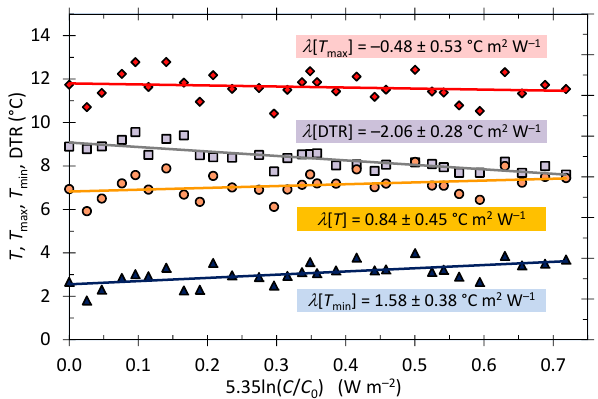
Fig. 7. Annual mean temperatures ( T , circles), maximum tem- peratures ( T max , diamonds), minimum temperatures ( T min , trian- gles), and diurnal temperature ranges (DTR, squares), calculated for each year 1977–2006, based on the hourly Mauna Loa Observa- tory, Hawaii temperature data (NOAA, 2009), given as a function of 5.35ln( C / C 0 ) (see Eq. 3), where C (CDIAC, 2009) is the an- nual mean concentration of CO 2 and C 0 =334ppmv is the reference value for 1977. Also shown for each temperature variable is the or- dinary least-squares best-fit line along with its slope λ ( ± 1s.e. of the slope), which is the equilibrium climate sensitivity λ from Eq.